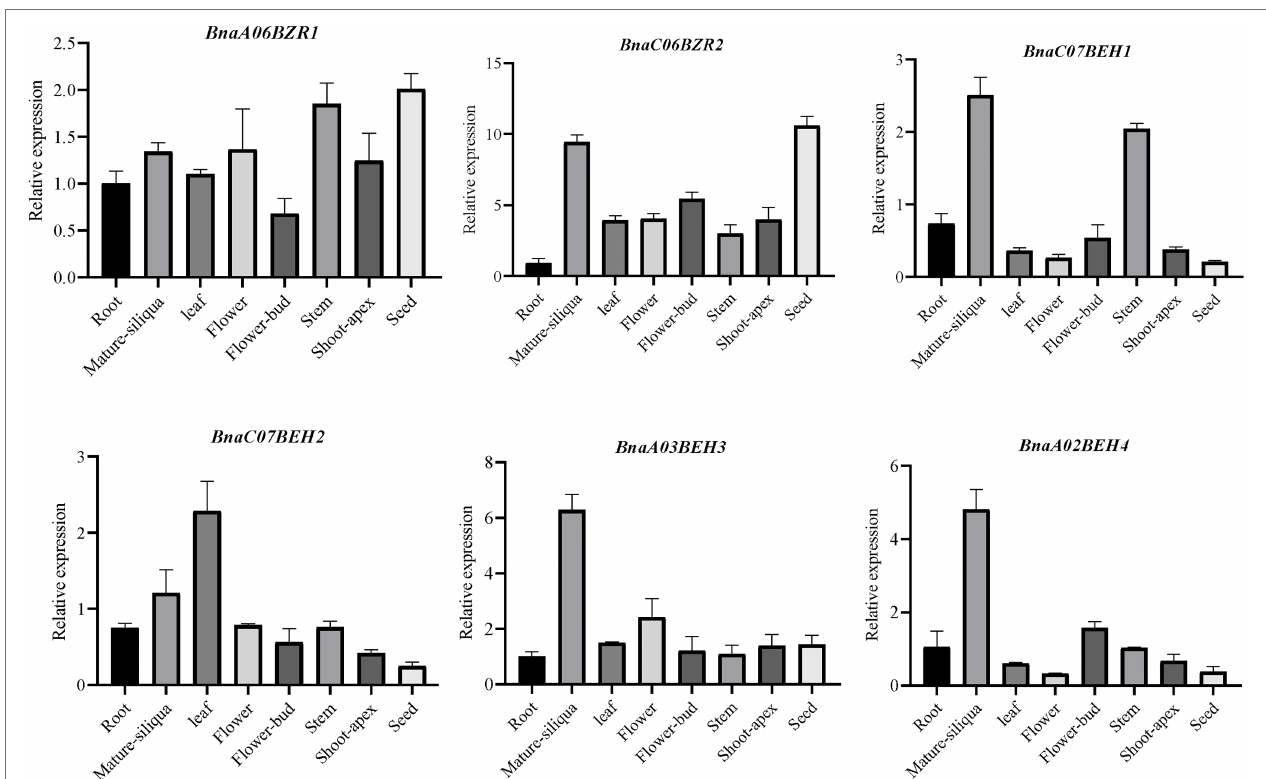
FIGURE 8 | Organ-specific expression pattern analysis of selected BnaBZRs in different tissues. The expression abundance of the specified BnaBZRs was adjusted with respect to the B. napus Actin gene. Tissues names are shown on the x -axis. The error bars on the y -axis represent the standard error of three independent biological replicates (listed in Supplementary Table S8.2